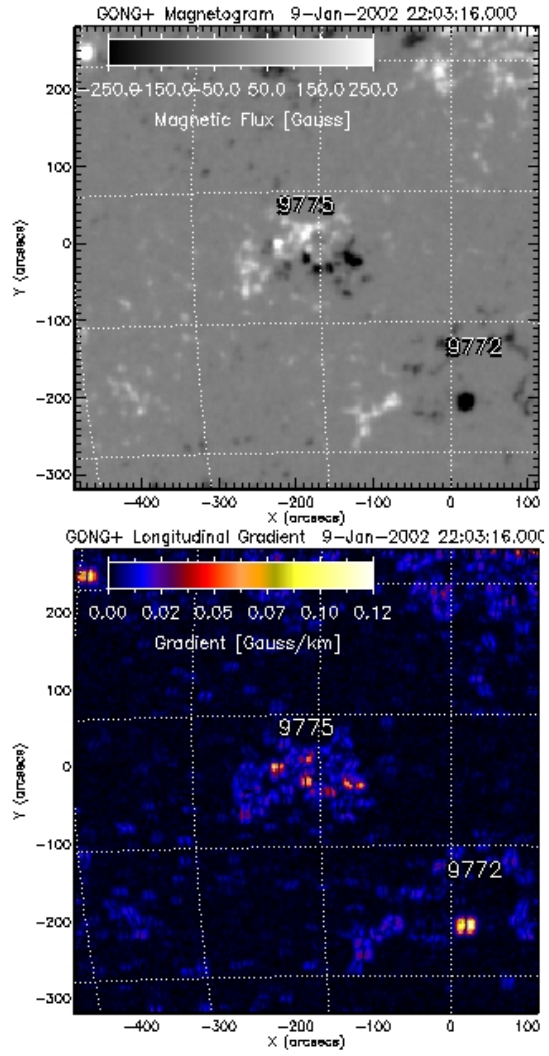
Fig. 5. The top panel gives a GONG + magnetogram taken at 22:03:16UT on 9 January 2002, while the derived gradient of the longitudinal magnetic field is given at